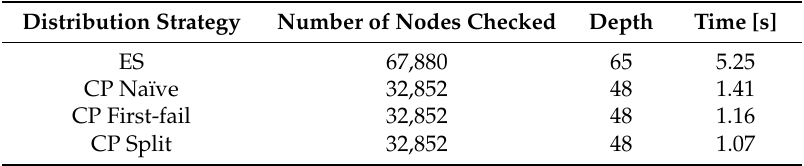
Table 3. A comparison of strategies for variable